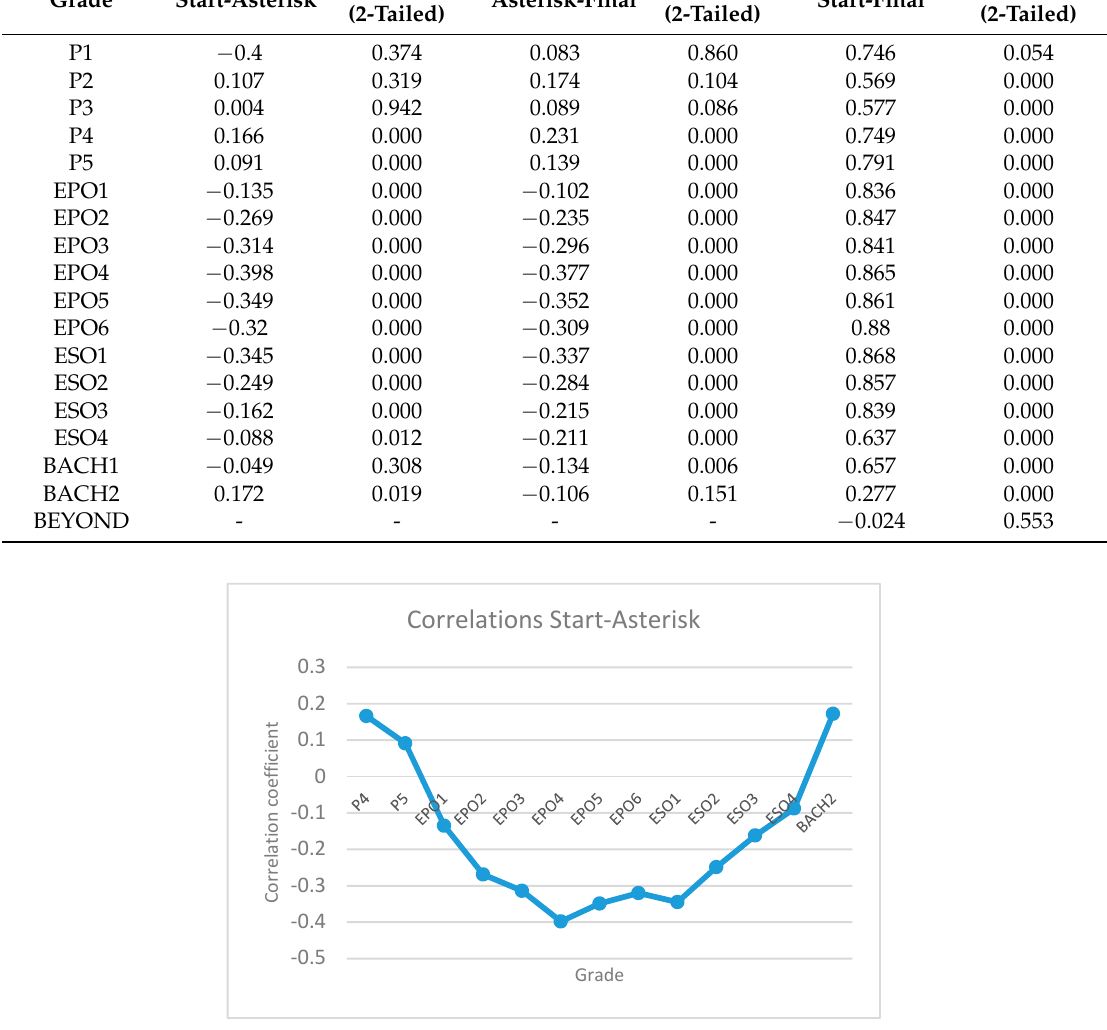
Figure 5. Start level–asterisk level correlation per school grade.